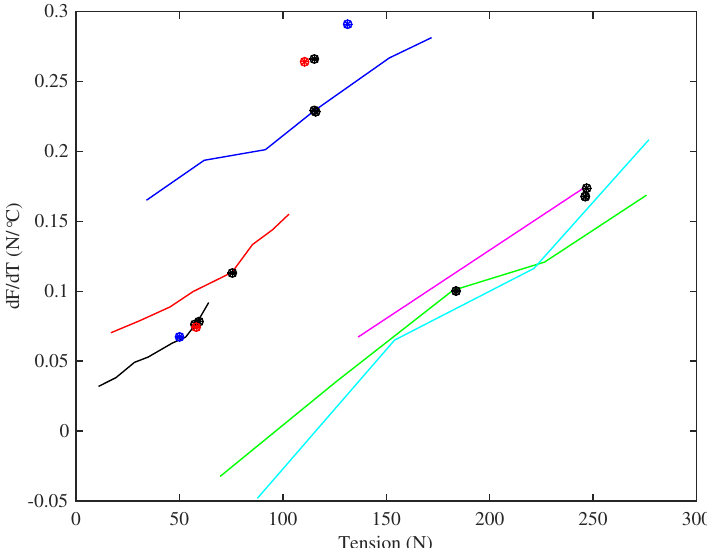
Figure 16. The thermal sensitivity dF / dT of the tension of the strings while held at constant length (with no tuning adjustments). The responses are plotted against the string tension F 0 at the base temperature (20 ◦ C) to illustrate the strong correlation between these two parameters. Colours identify the di ff erent tested strings (Table 1): black (8:A6), red (14:A5), blue (5:A4), green (23a:A3), cyan (29:E3), magenta (10b:A2). Black circles show the results at the expected operating points for the Bowbrand strings tested at the usual humidity levels (around 55–65% RH at 20 ◦ C); blue circles show Pirastro strings; red circles show tests at low humidity (around 20–26% RH at 20 ◦